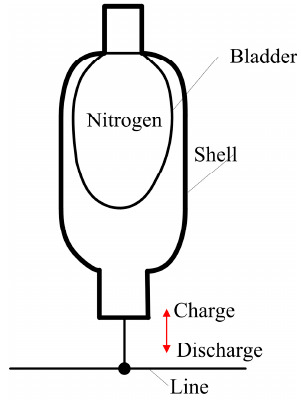
Figure 4. Sketch map of the bladder accumulator.